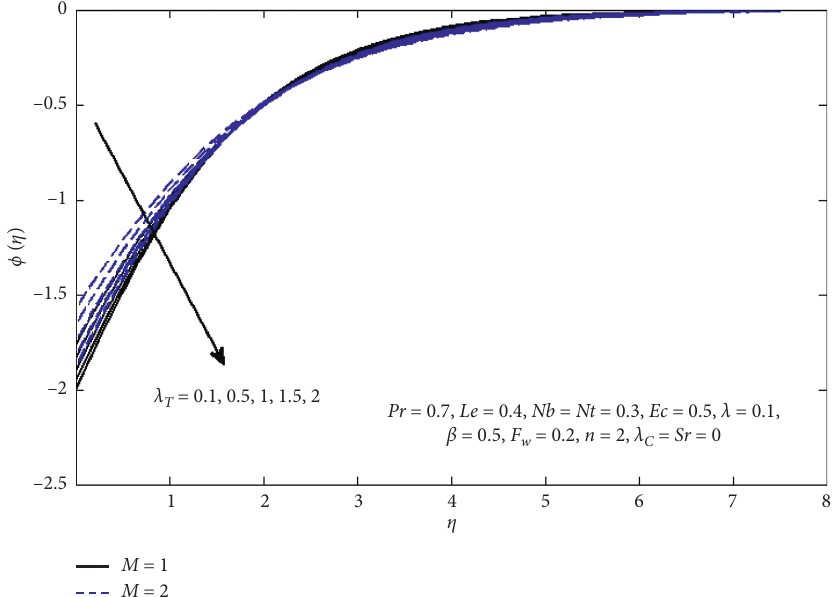
Figure 7: Distinction of concentration ϕ concerning η with various values of λ